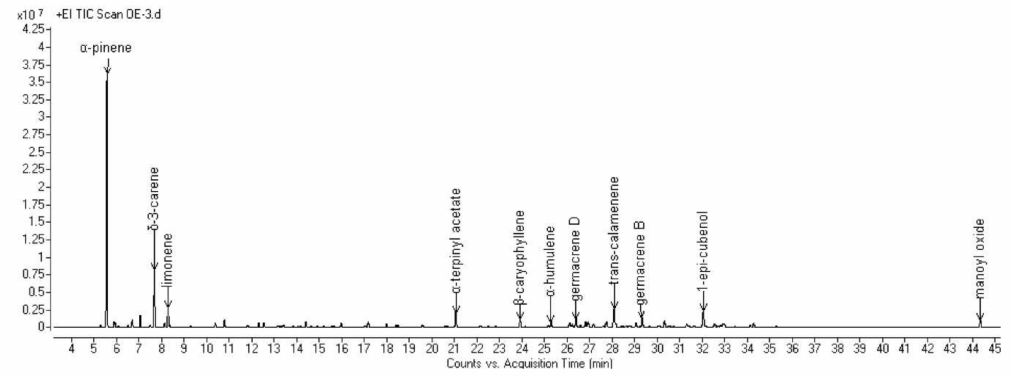
Figure 2. GC chromatogram of the EO hydrodistilled from the aerial parts of A. herba-alba Asso.